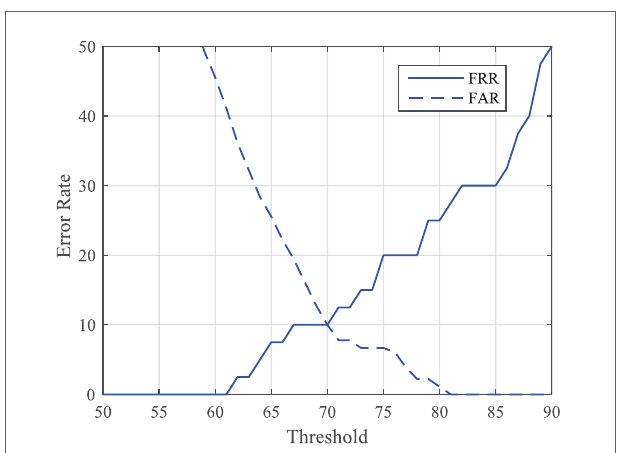
FigUre 6 | False rejection rate (Frr) and false acceptance rate (Far) of synergy 1, when using all 10 joints . Equal error rate (EER) is calculated at the intersection of these plots. EER is 10% at a threshold of 70% correlation.